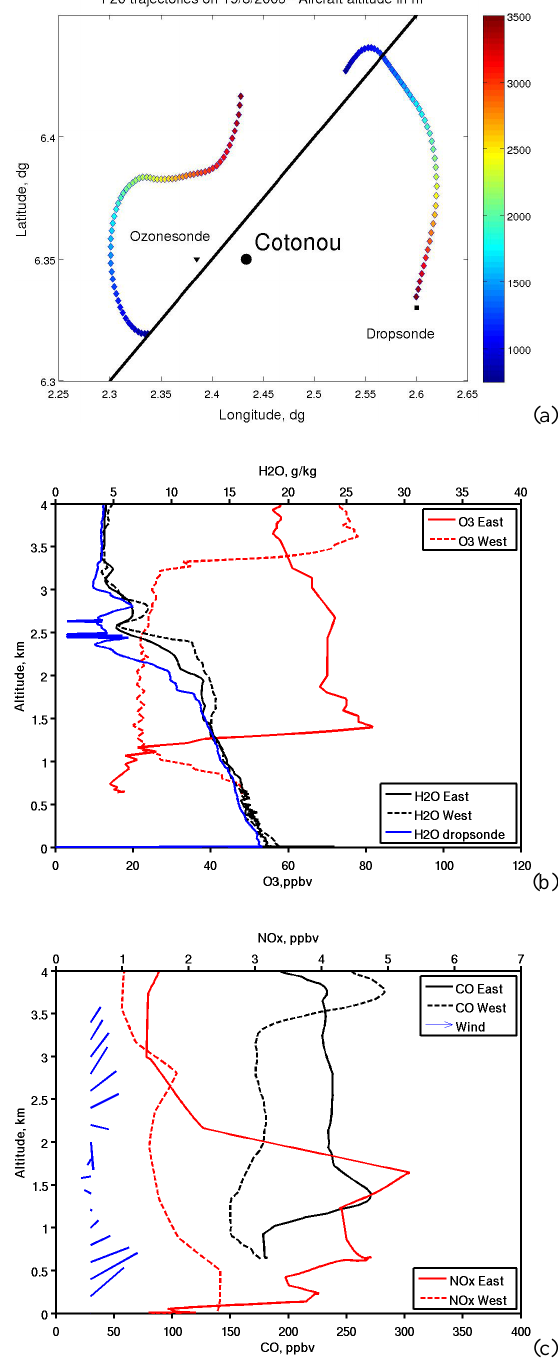
Fig. 2. (a) Map of the FF20 positions (colour scale is altitude in m) around Cotonou on 19 August. The black solid line sep- Fig. 2. (Top panel, (a) ) Map of the FF20 positions (colour scale is altitude in m) around Cotonou on arates the ozone rich (East) and poor (West) area. (b) O 3 , H 2 O August 19. The black solid line separates the ozone rich (East) and poor (West) area. (Bottom panel, and (c) CO, NO x vertical profiles measured by the FF20 west and O (left) and CO, NO (b,c) )) O , H (right) vertical profiles measured by the FF20 west and east of east of Cotonou. The H 2 O dropsonde vertical profiles (b) describes 3 2 x the PBL evolution between 10:45UT and 13:45UT. The dropsonde O dropsonde vertical profiles (left) describes the PBL evolution between 10:45 UT and Cotonou. The H 2 wind direction vertical profile (c) shows the weakening of the south- 13:45 UT. The dropsonde wind direction vertical profile (right) shows the weakening of the southeasterly easterly flow (base of the wind vector on the solid flow (base of the wind vector on the solid line).